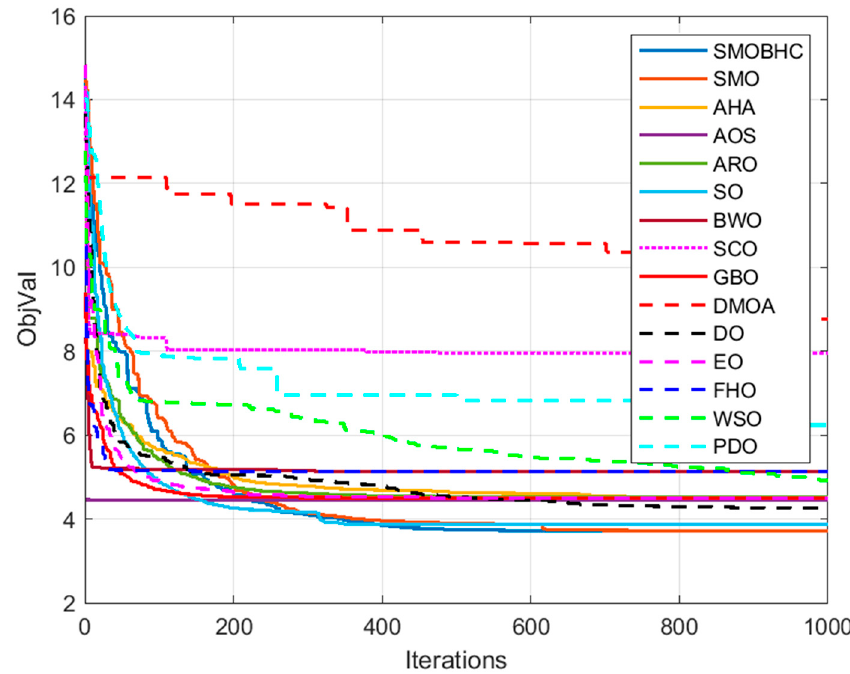
Figure 19. Comparative convergence curves of algorithms for battlefield 3 with 𝐷 = 60 .